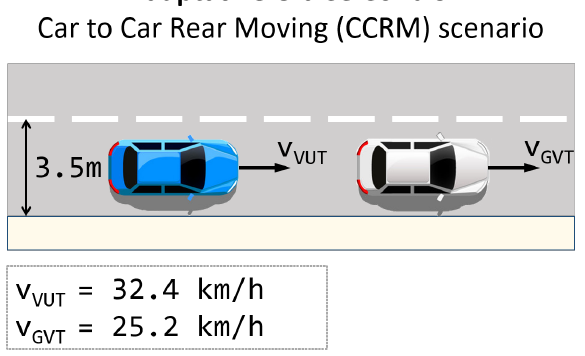
Figure 6. Adaptive cruise control scenario. Ego-vehicle is represented in blue and the other agent in white.